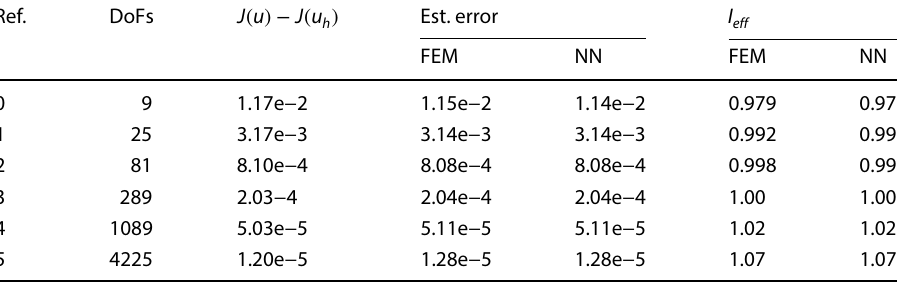
Table 1 Section 5.1.1: Error estimator results for mean value goal functional